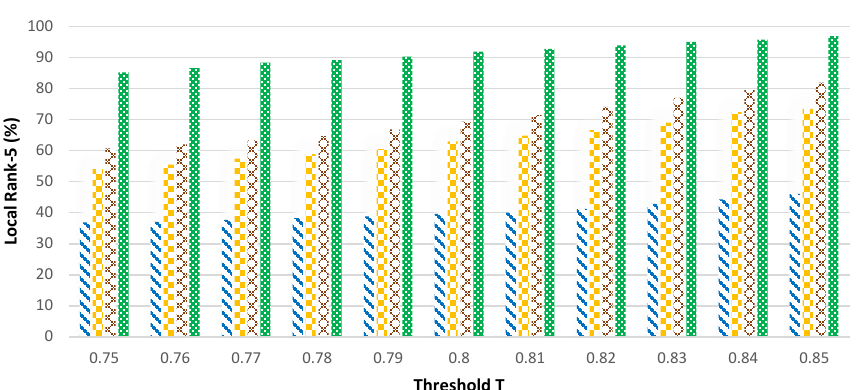
Figure 8. Histogram of the local rank-5 based on four segmentation